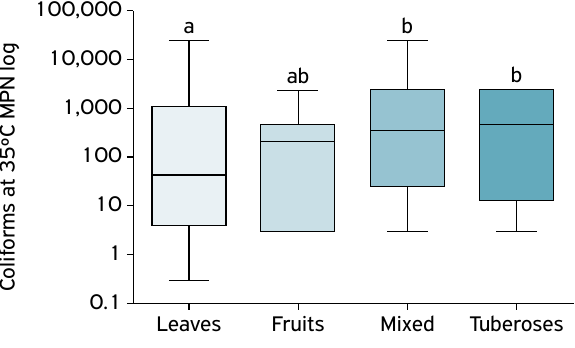
Figure 1. Coliforms at 35ºC MPN log for samples distributed in